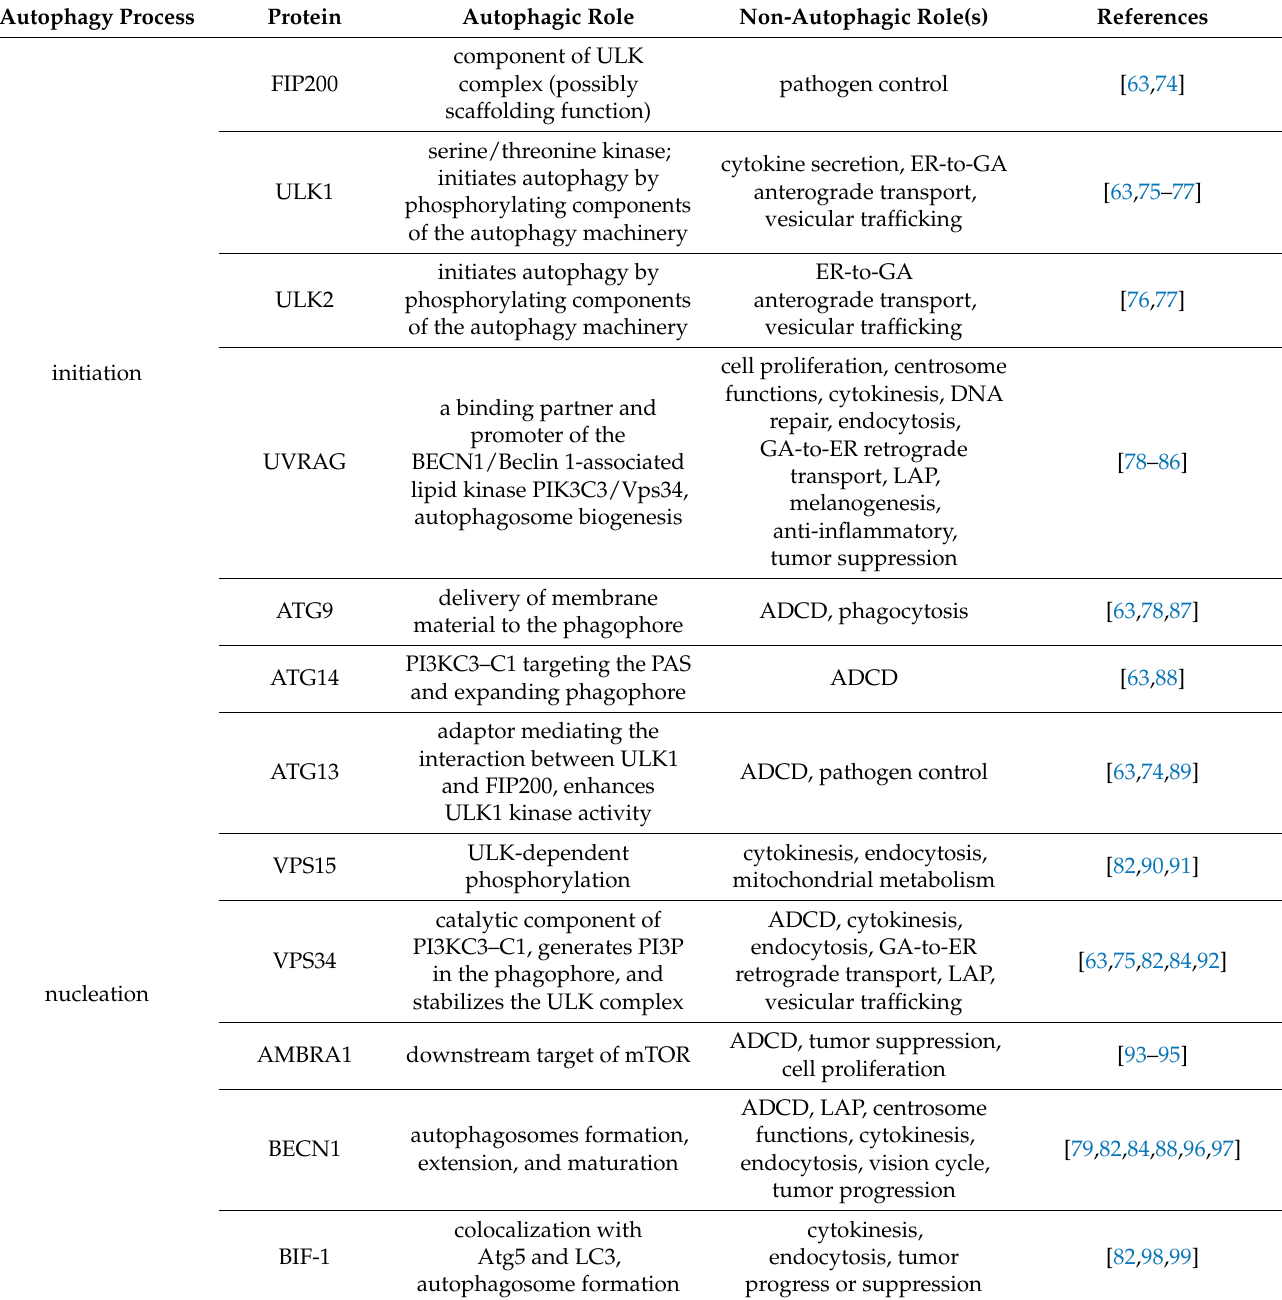
Table 1. Canonical and non-canonical function of autophagy-related